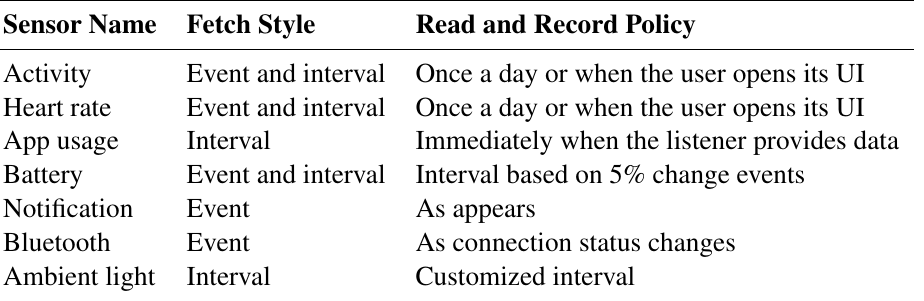
Table 1. Implemented sensors and their sensor data fetch